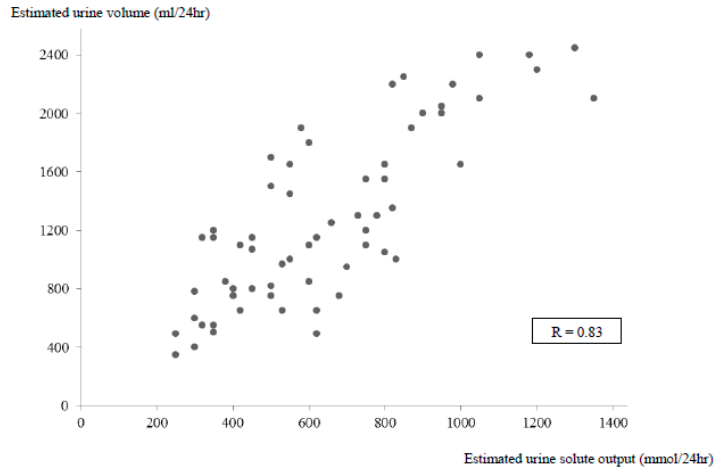
Figure 4. Correlation between the estimated solute output and the estimated urine volume in 65 patients with SIADH. In our control group with exact 24 h urine collection, the difference between the measured and calculated solute or urine volumes never exceeded 20% (data not shown). In our 30 patients with SIADH, the difference between the measured or calculated values of urine volume or solute output never exceeded 22% (data not shown). In normal subjects with urine osmolality higher than serum osmolality, we also observed a correlation between FE.Osm and V/eCcr (%), however this was less significant (y = 0.017 + 0.605 x; r = 0.58; p < 0.001) (data not shown) than in the SIADH patients (y = 0.025 + 0.519 x; r = 0.78; p < 0.001) (Figure 1). As expected, FE.Na was correlated with FE.Osm (y = 0.156 + 0.455 x; r = 0.66) or with diuresis expressed by V/eCcr ( r = 0.64), however diuresis was better correlated with FE.Osm ( r = 0.78) (Figure 1). Table 2 shows the data of three patients. The first patient (J.P.) had idiopathic SIADH with chronic hyponatremia for many months previously. For this patient, the calculated solute intake and calculated urine volume were similar to the real measurements. The FE.Osm was 1.7% and the V/eCcr was low at 0.62%, meaning an estimated urine volume of 795 mL (0.089 L/min × 1440 × 0.0062 = 0.795 L/24 h). If we assume that fluid intake was between 800 mL and 1100 mL (urine volume + 300 mL), it is easy to see that it will be difficult to comply with more strict water restriction in the long term.